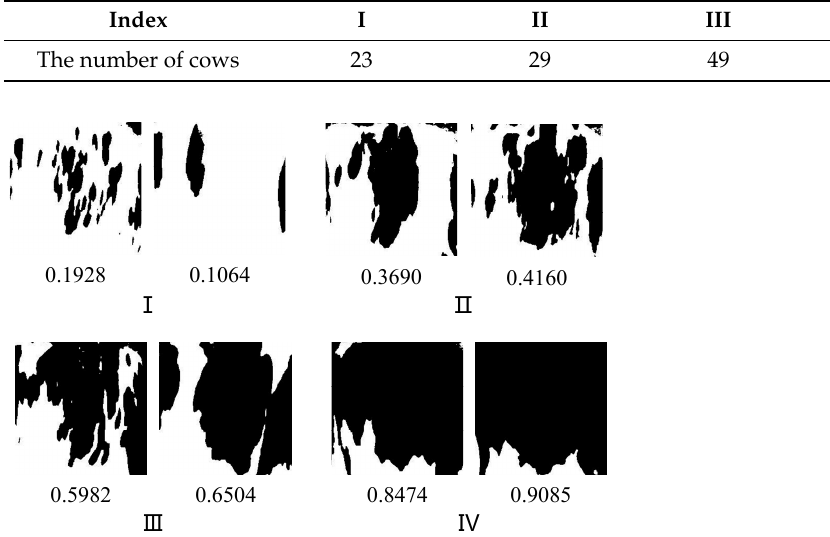
Figure 10. Binarized cow body pattern images in four categories. In the figure, the number below each image represents the proportion of black pixels in that image. each image represents the proportion of black pixels in that image.